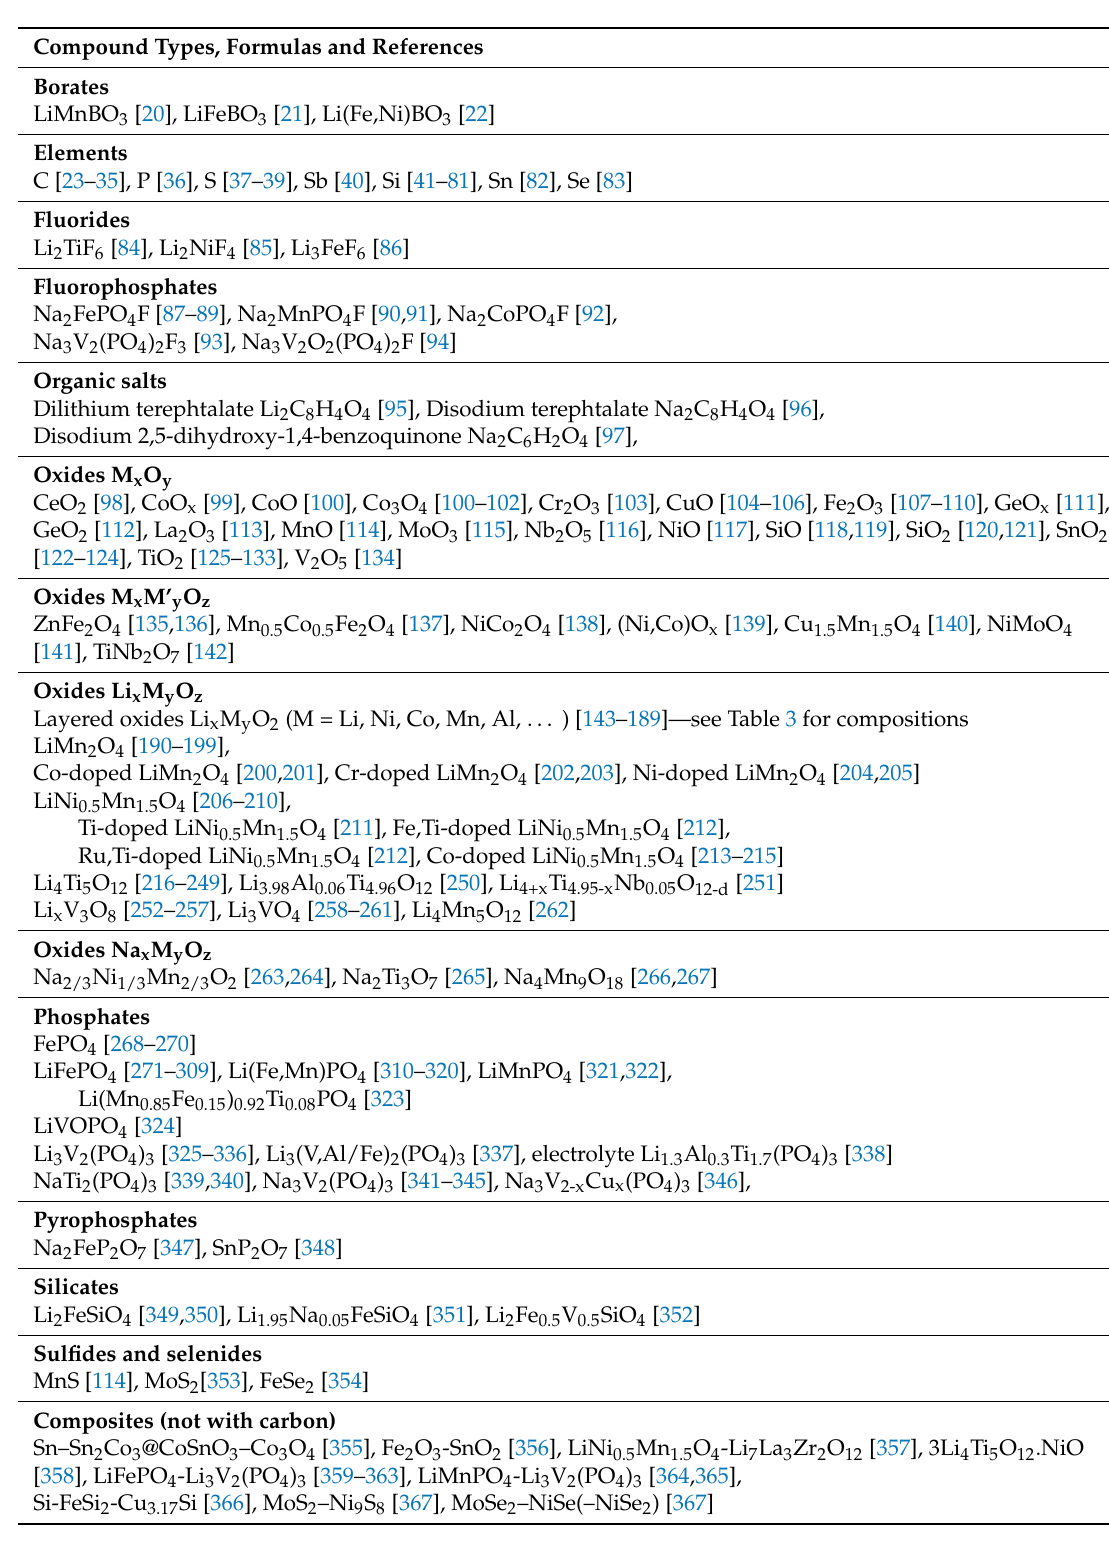
Table 1. Bibliographical